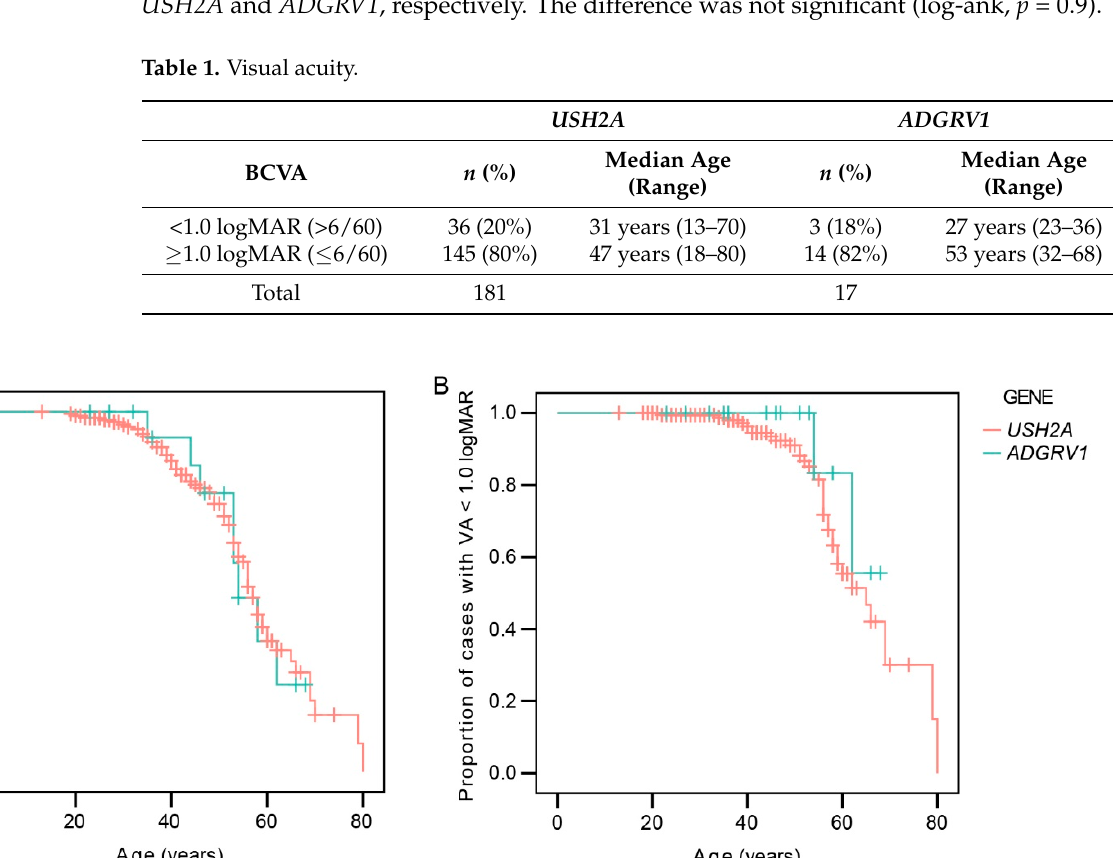
Figure 1. Boxplot chart showing the ages at onset of nyctalopia in the two patient groups. Horizontal lines represent the median values, boxes represent half of the data for each group/mutation, and whiskers represent the remaining data except in the case of the outliers (circles). Red color repre- sents USH2A patients and green color represents ADGRV1 patients.